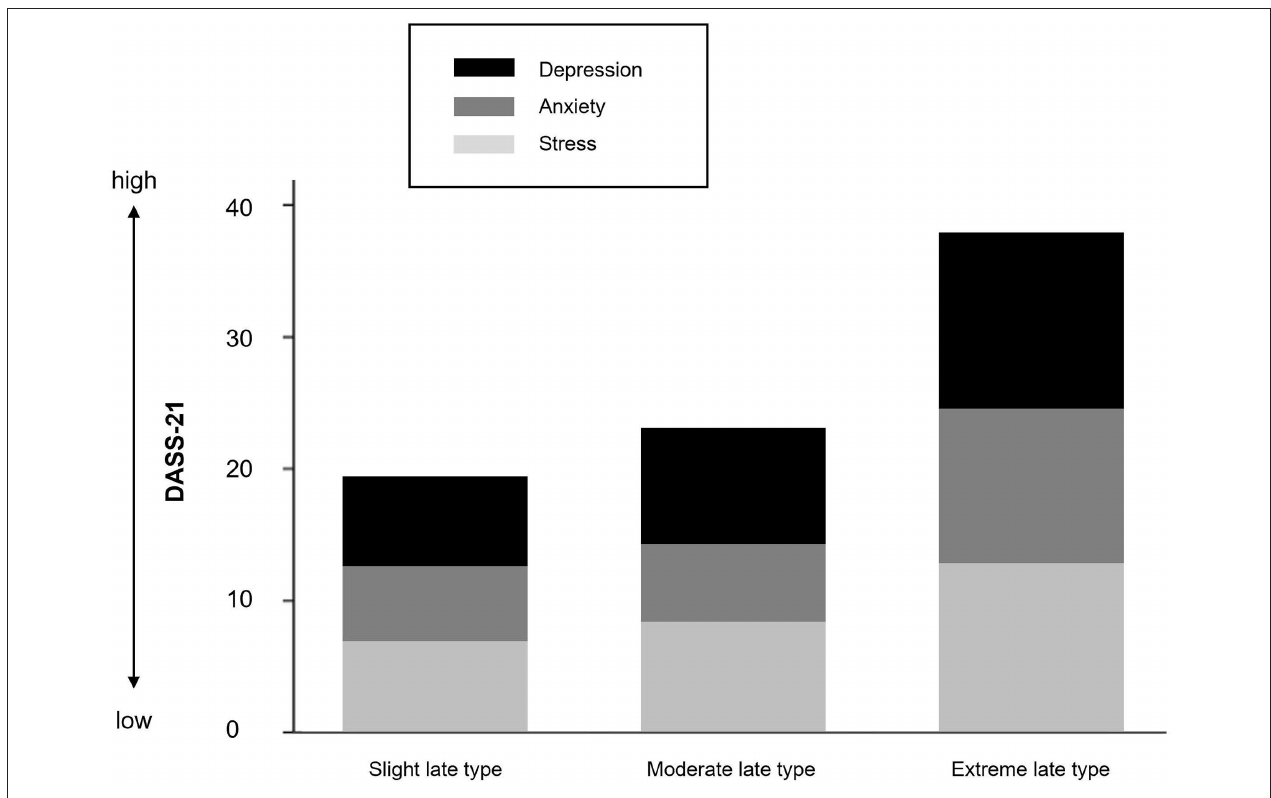
FIGURE 5 | Stacked mean of depression, anxiety, and stress scores separately for